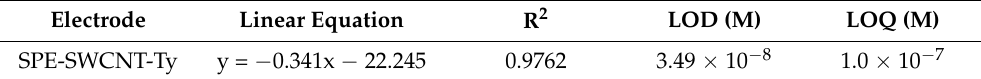
Table 3. Linear dependence equation, R 2 , LOD and LOQ for the two modified electrodes.